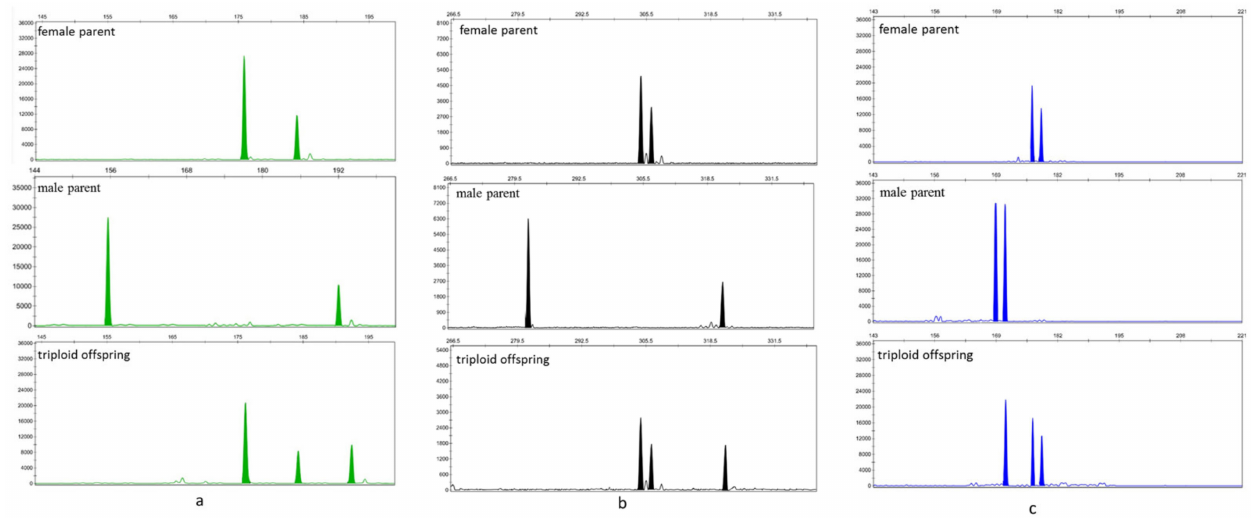
Figure 8. Allele configurations of three pairs of primers in triploid hybrids. ( a ) BFU 0308; ( b ) BFU 0377; ( c ) BFU 1205. Each row represents the female parent, male parent, and triploid offspring,